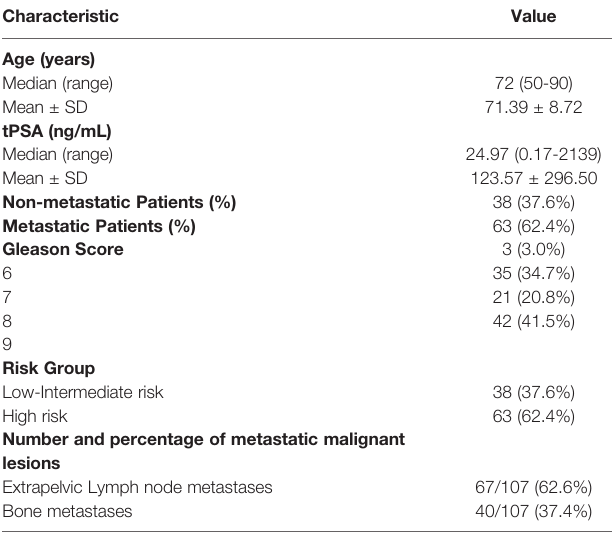
TABLE 1 | Demographic and clinical characteristics of the 101 study participants. Characteristic